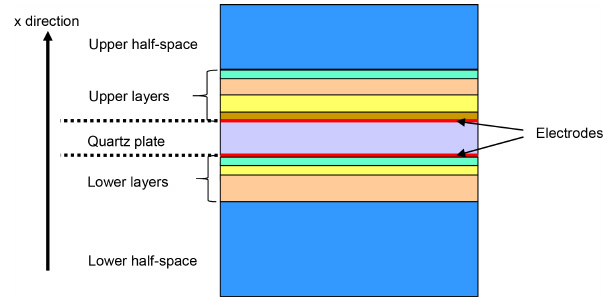
Figure 1. One-dimensional material configuration consisting of a piezoelectric plate, such as quartz, with electrodes, stacks of layers, and half-spaces on both